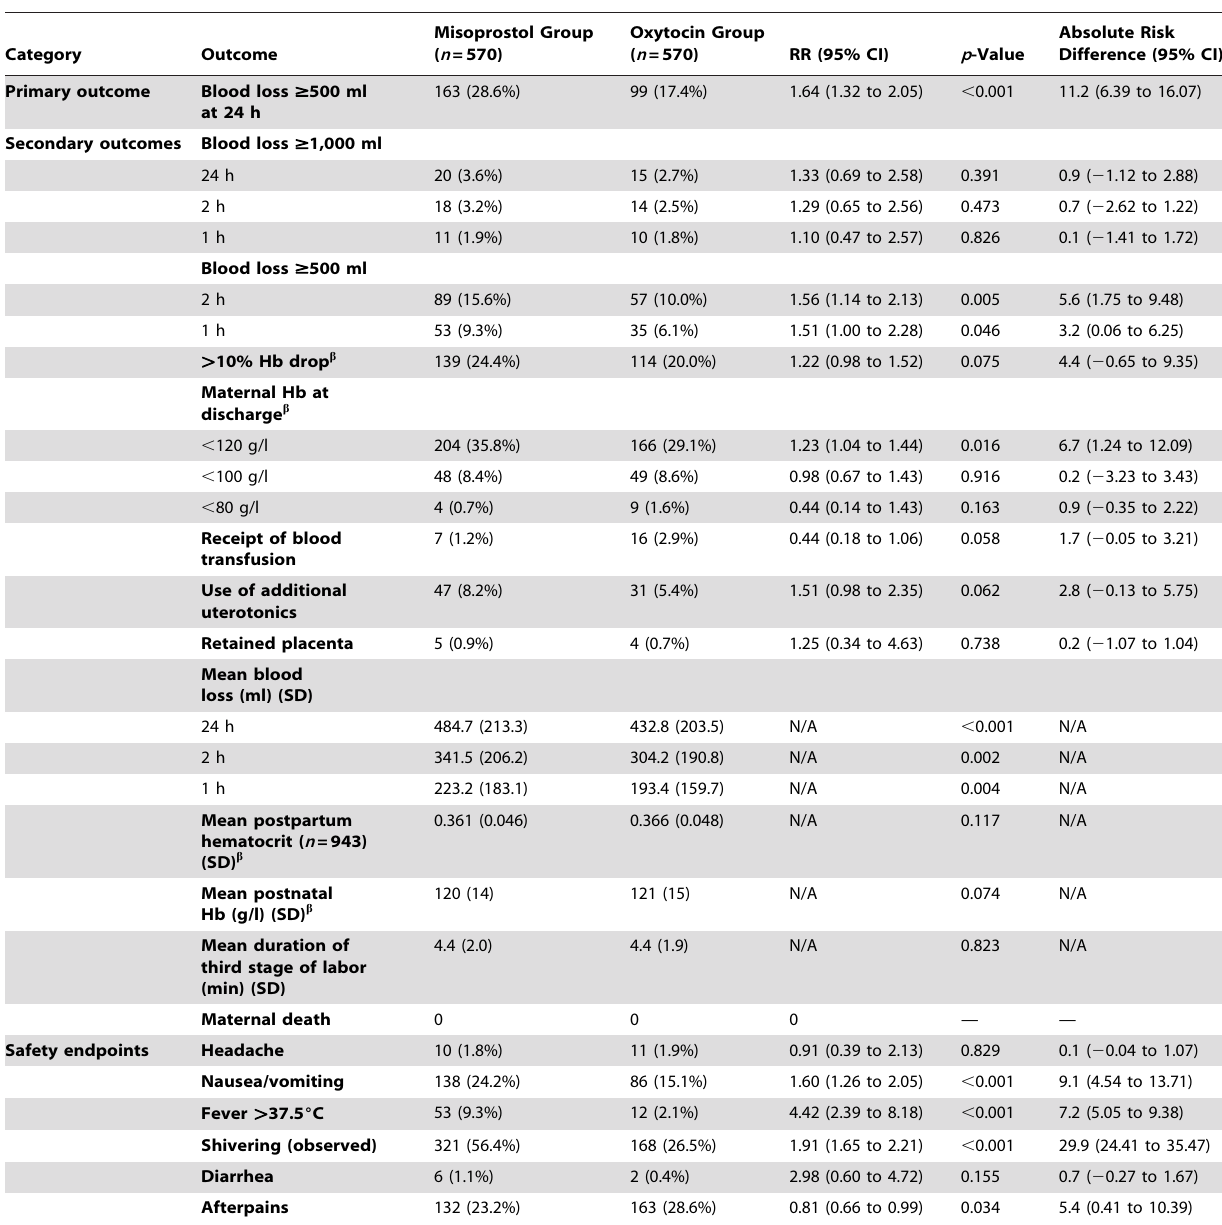
Table 2. Primary and secondary outcomes by treatment